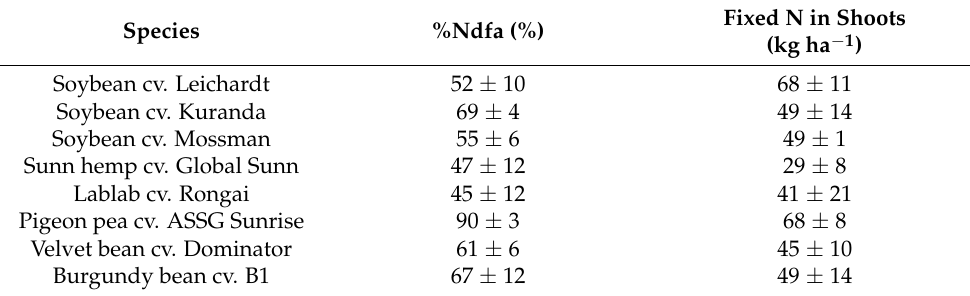
Table 3. Percent nitrogen derived from atmosphere (%Ndfa) and total fixed nitrogen in shoots of legumes grown in trial 2 (2018–2019). Means are shown ± SEM ( n = 3). Fixed N in Shoots Species %Ndfa (%) (kg ha − 1 ) Soybean cv. Leichardt 52 ± 10 68 ± 11 Soybean cv. Kuranda 69 ± 4 49 ± 14 Soybean cv. Mossman 55 ± 6 49 ± 1 Sunn hemp cv. Global Sunn 47 ± 12 29 ± 8 Lablab cv. Rongai 45 ± 12 41 ± 21 Pigeon pea cv. ASSG Sunrise 90 ± 3 68 ± 8 Velvet bean cv. Dominator 61 ± 6 45 ± 10 Burgundy bean cv. B1 67 ± 12 49 ±